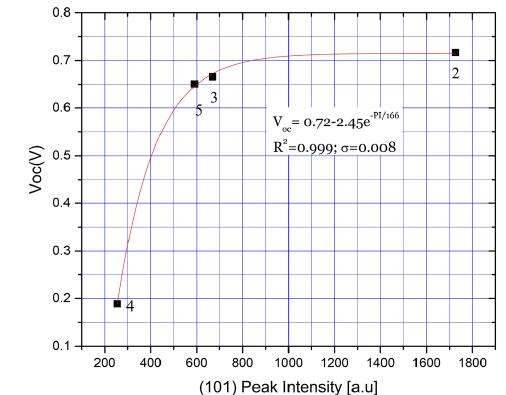
Figure 9. Open-circuit voltage V (101) peak intensity.